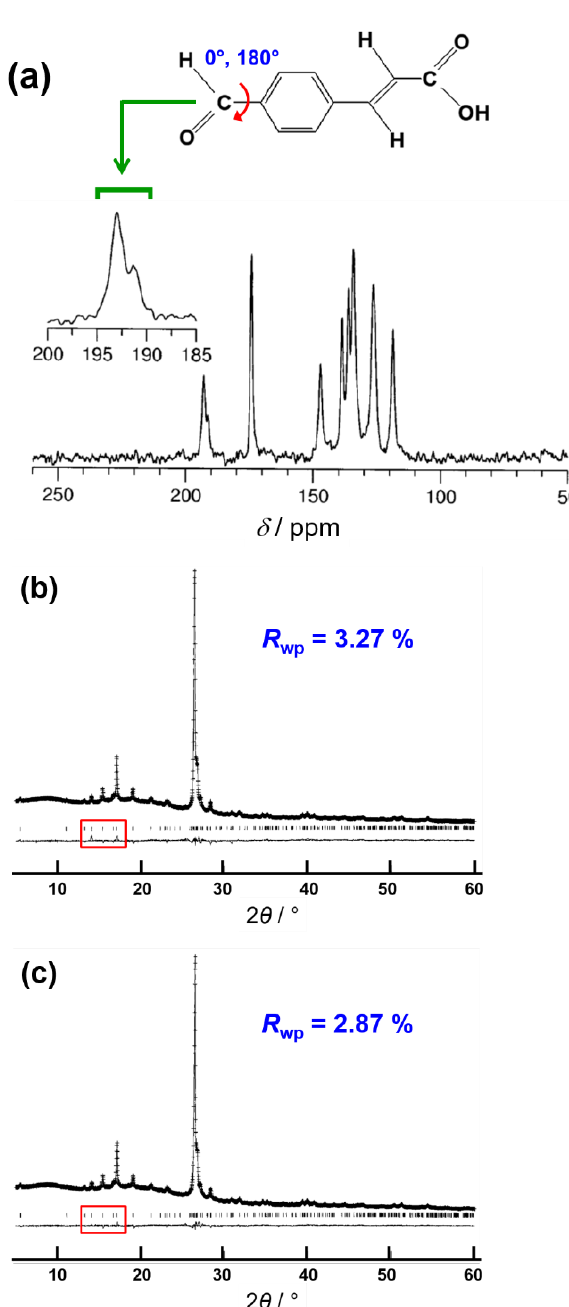
Figure 6. ( a ) Experimental high-resolution solid-state 13 C NMR data recorded for the β polymorph of p -FCA, showing the presence of two peaks for the 13 C environment of the formyl group, which is interpreted to arise from disorder between two orientations of the formyl group. ( b ) Rietveld refinement for the ordered structural model of the β polymorph of p -FCA ( R wp = 3.27%). ( c ) Rietveld refinement for the disordered structural model of the β polymorph of p -FCA ( R wp = 2.87%). Apart from the description of the order/disorder of the formyl group, all other aspects of the refinement calculations are the same in ( b , c ). The red boxes in ( b , c ) highlight the region of the powder XRD pattern corresponding to the greatest improvement in the quality-of-fit for the disordered model, assessed from the difference between the experimental and calculated powder XRD